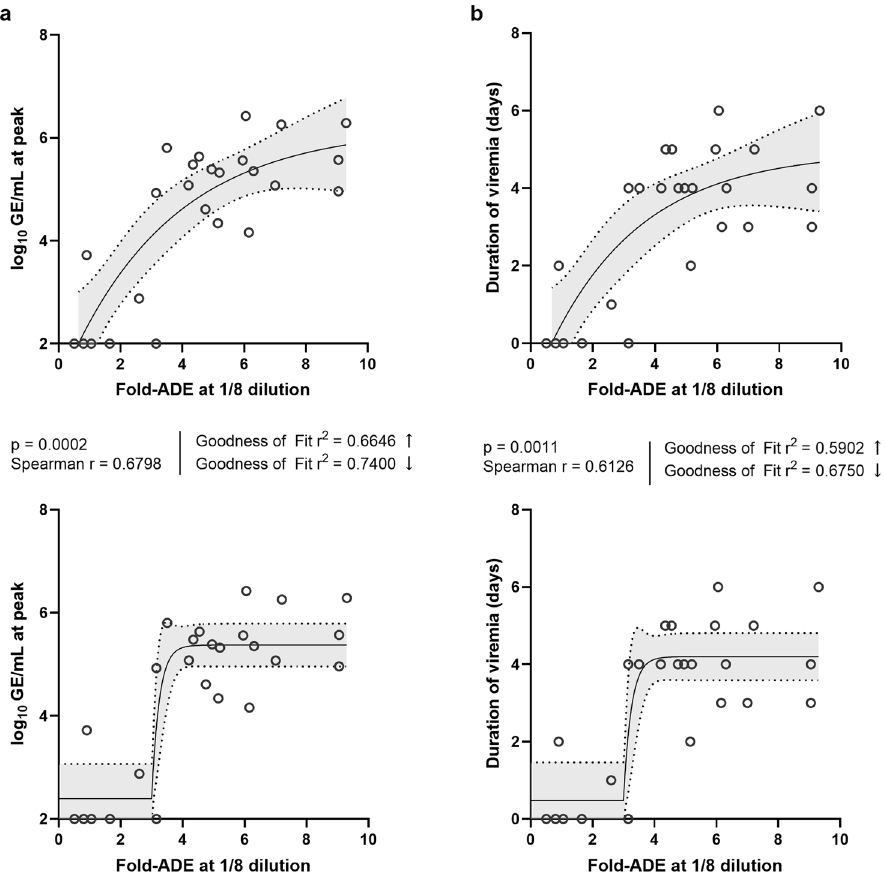
Fig. 6 Relationships between in vitro ADE and viremia. Spearman correlations and non-linear regression analyses between in vitro fold-ADE of day 28 sera at a 1/8 dilution and either peak LAV viremia ( a ) or duration of LAV viremia ( b ) were performed. The upper panels show the data fi t with an exponential, one-phase association curve with unconstrained parameters. The lower panels show the data fi t similarly, but using an initial plateau region constrained to a fold-ADE value of 3. Use of the initial plateau region increased the Goodness of Fit r 2 value by >11%. Shaded regions represent 95% con fi dence